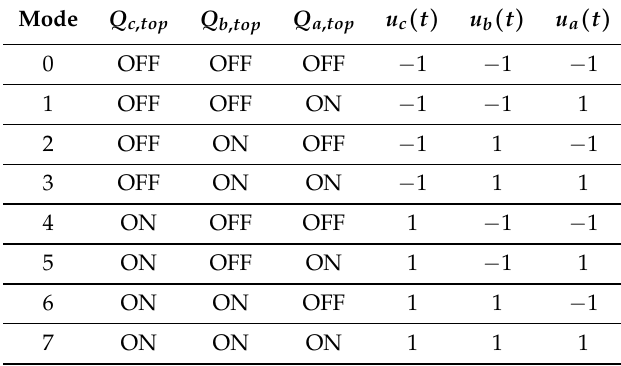
Figure 2. Mode 1 of operation. Table 1. Switching arrangements in different modes of